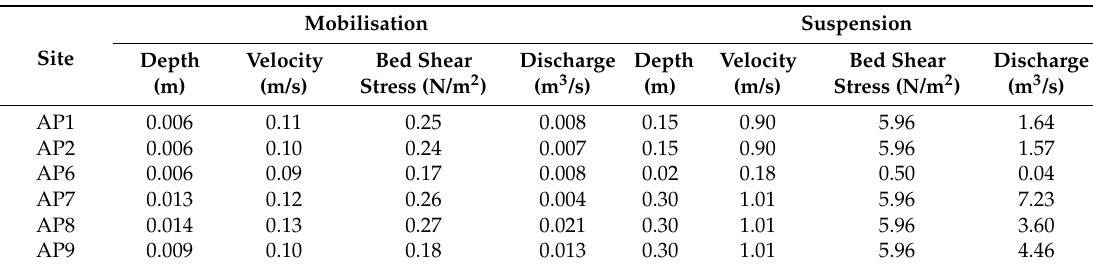
Table 3. Estimated sediment mobilisation and suspension flow conditions for sampling sites on the Apies